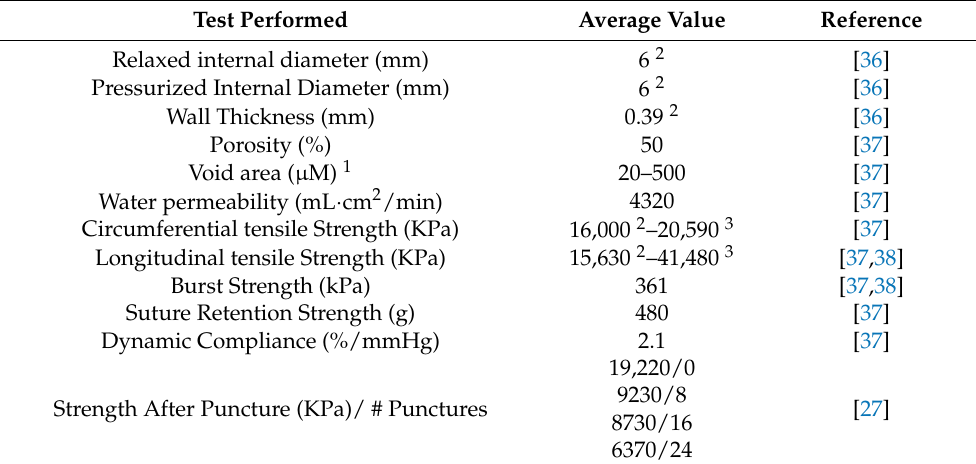
Table 2. Mechanical properties in average commercial PTFE vascular grafts for Arteriovenous Fistula with 6 mm internal